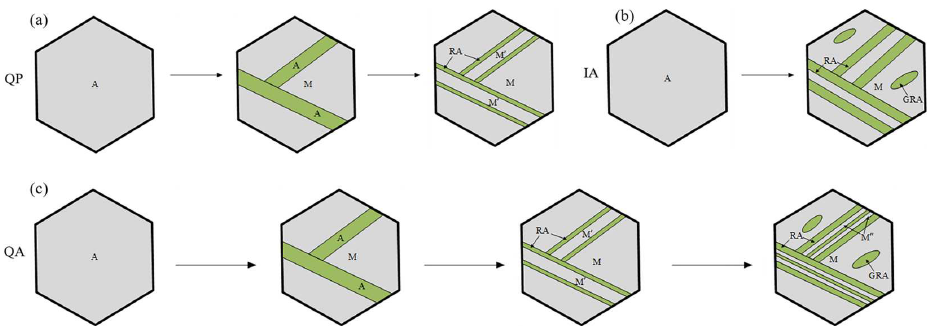
Figure 12. Schematic diagrams of the microstructure transformation mechanisms of ( a ) QP-300, ( b ) IA-680 and ( c ) QA-680 processes.